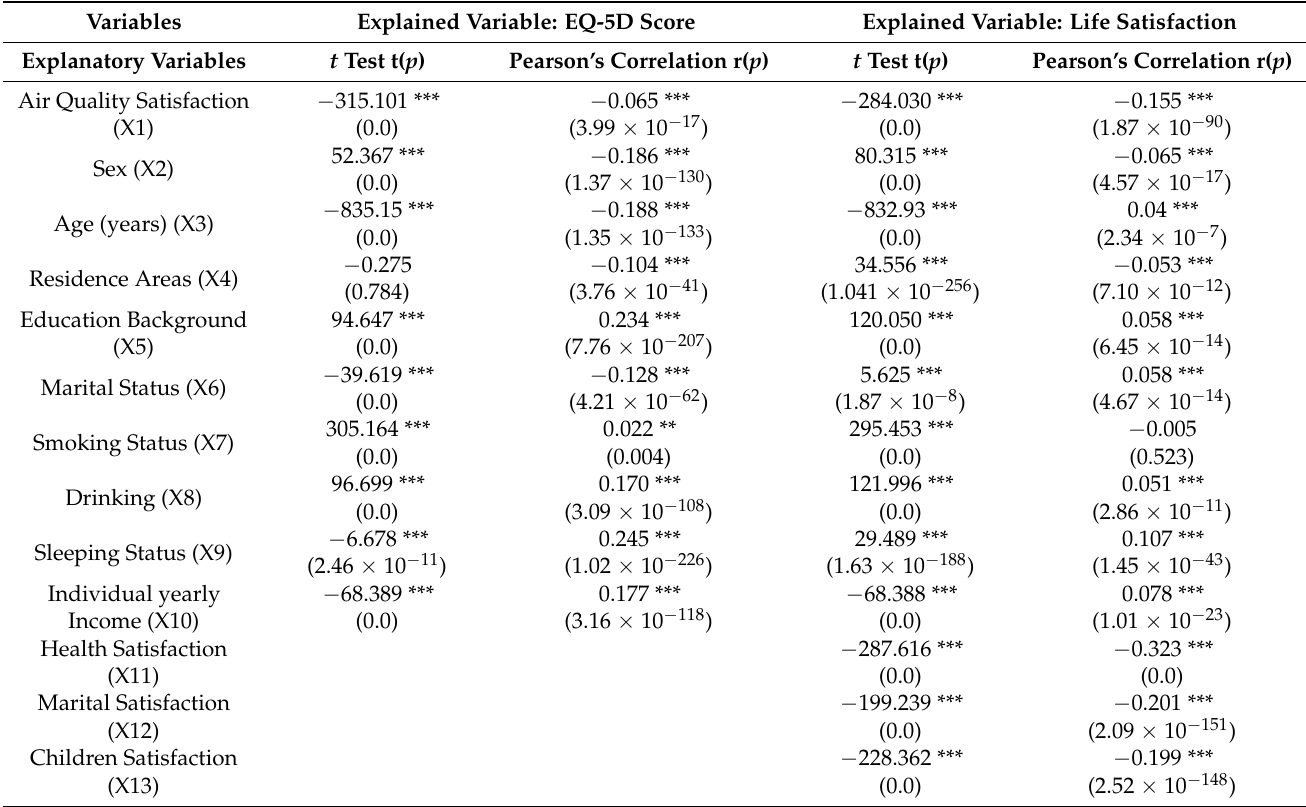
Table 3. T -test and Pearson’s correlation of influencing